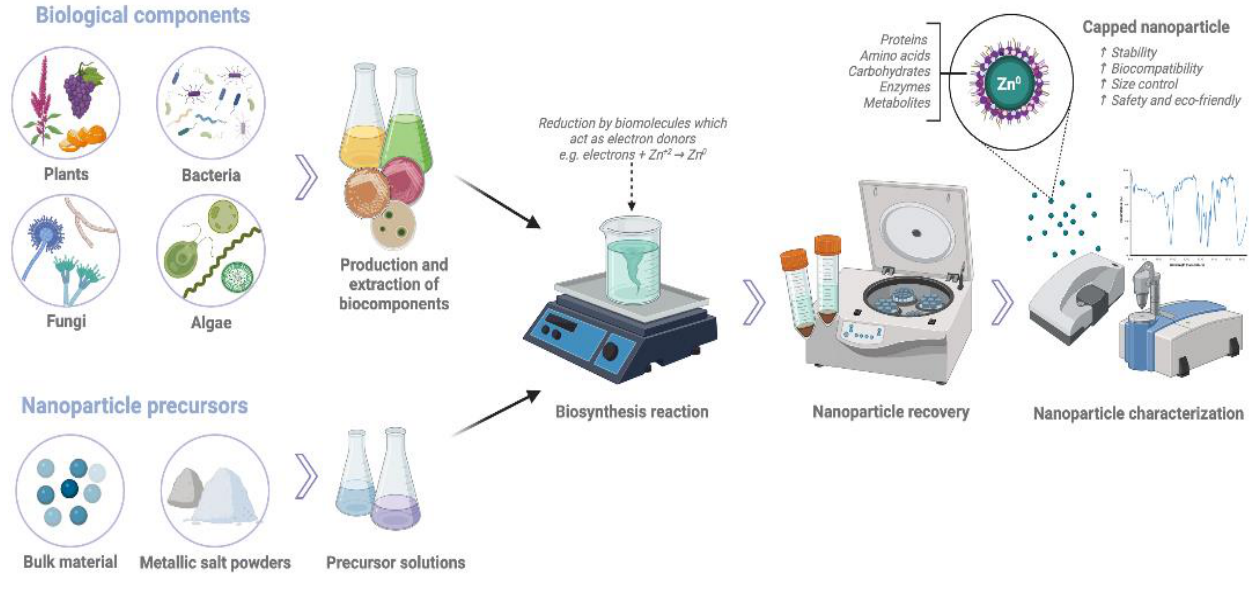
Figure 4. Biological or green synthesis methods for nanoparticle production. Figure created with BioRender.com.